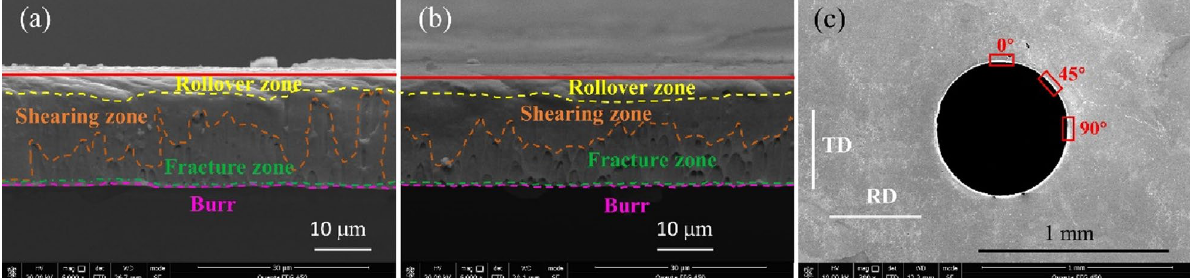
Figure 6. Micro-hole cross-section and its observation position. (a) Micro-hole cross-sections in non- ultrasonic punching experiments. (b) cross-sectional view of micro-hole in Micro-USF punching experiment. (c) micro-hole cross-section observation